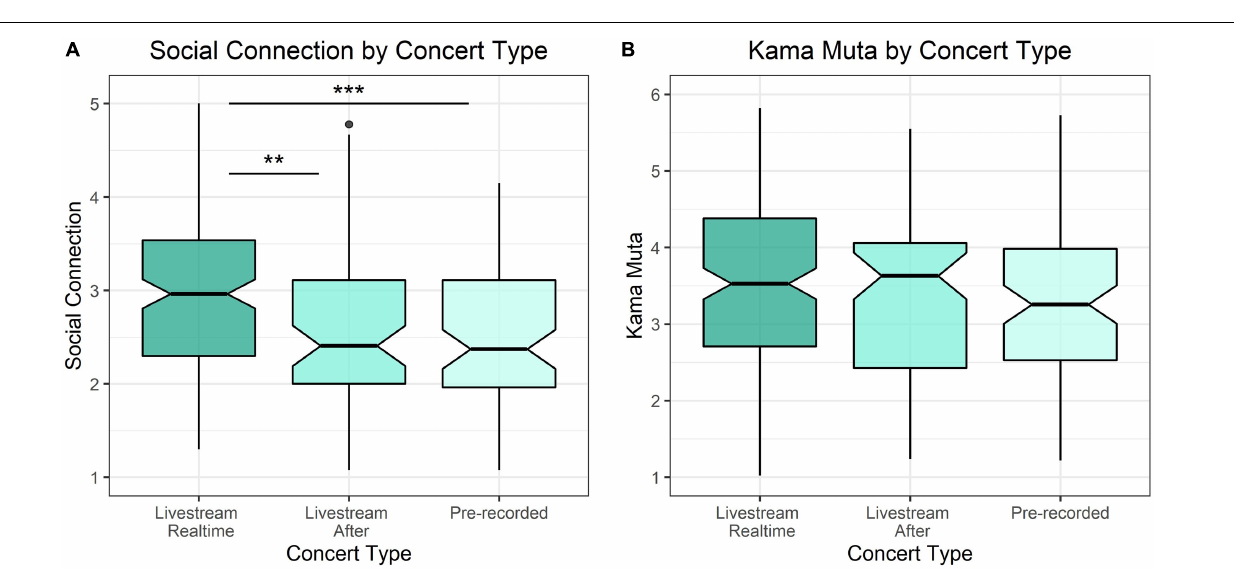
η 2 = 0.010, p = 0.20] (see Figure 2 ). A Tukey post-hoc